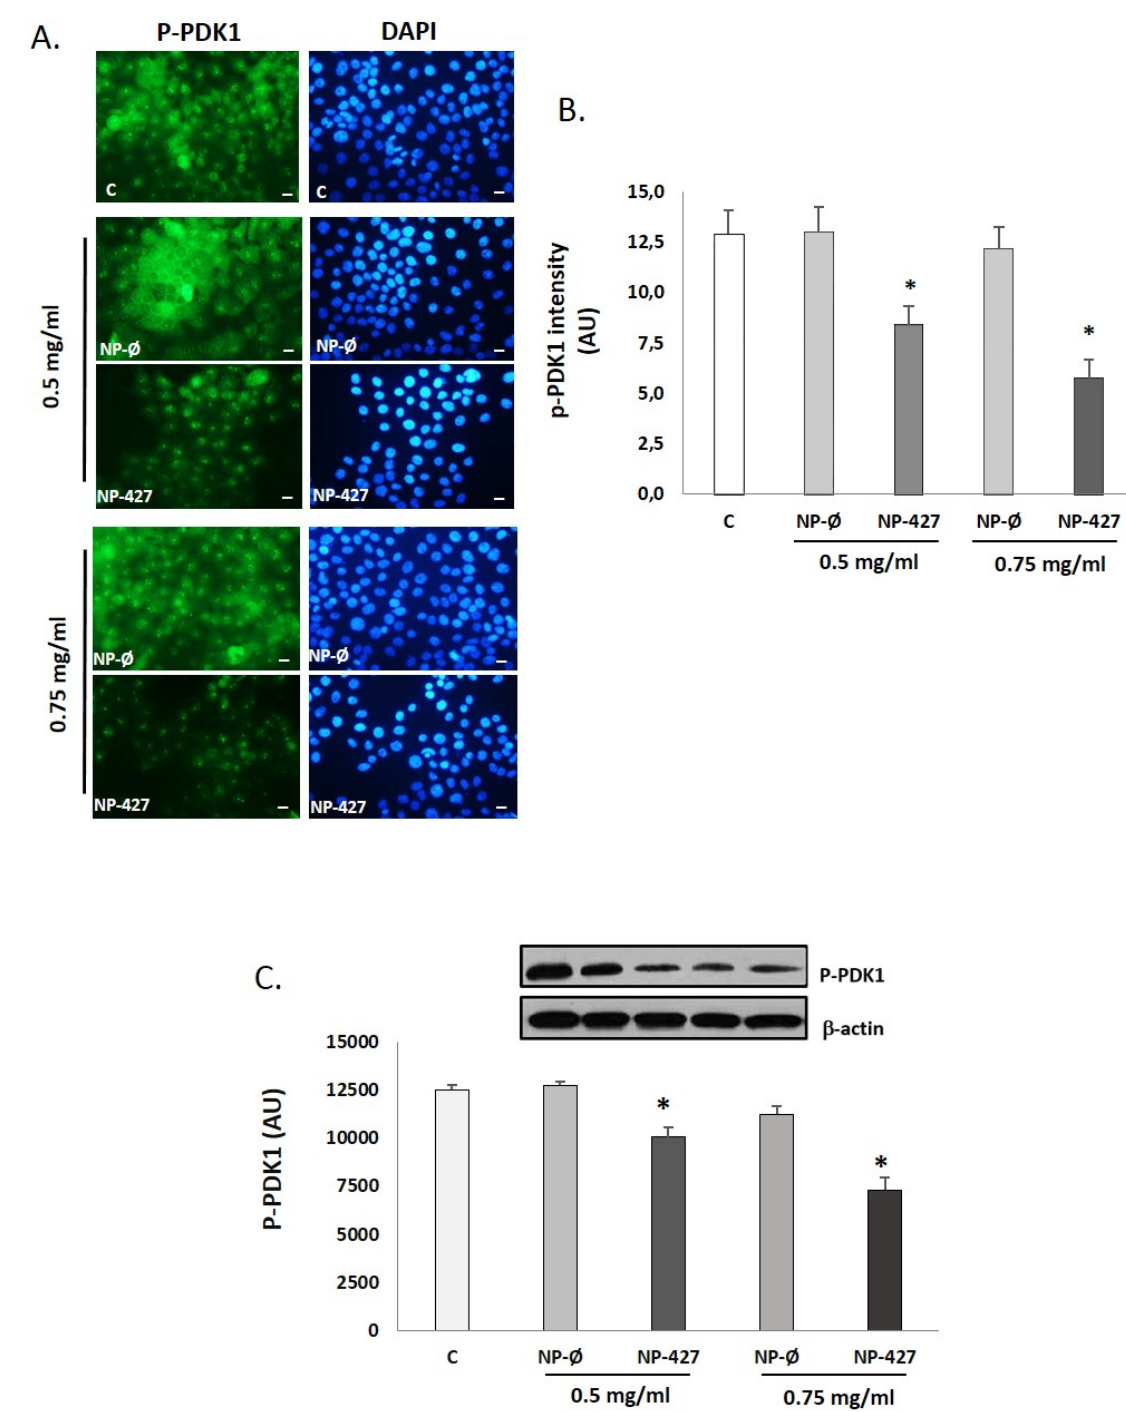
Figure 7. p-PDK1 levels decrease with the treatment of nanoparticles loaded with PHT-427 on FaDu cells. ( A ) Representative fluorescence images of the immunostaining of p-PDK1-Ser241 (green fluorescence) in FaDu cultures treated with C (control), NP-Ø (unloaded NPs, 0.5 and 0.75 mg/mL), and NP-427 (PHT427-loaded NPs, 0.5 mg/mL and 0.75 mg/mL) for 24 h. DAPI labels nuclei with blue fluorescence. Scale bar 100 µm. The images were taken at random in a blinded fashion. ( B ) The bar graphs show the immunofluorescence intensity changes for PI3KCA by Image J. ( C ) The p-PDK1-Ser241 protein levels were analyzed by Western blotting in FaDu cells. Densitometry analyses for each experimental group are shown. Loading control: β -actin. The diagrams represent the mean ± SD of arbitrary units (AU). * p < 0.05 vs. C and NP-Ø groups ( n = 4).